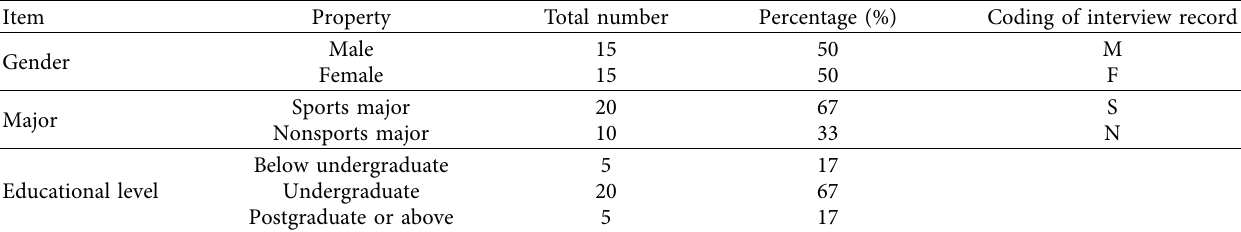
Table 1: The basic information of interviewees.